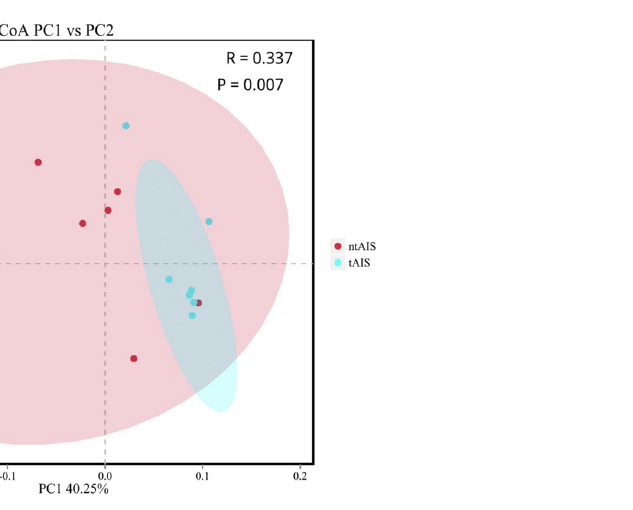
Fig 2. PCoA analysis of the microbiota between tAIS and ntAIS groups.